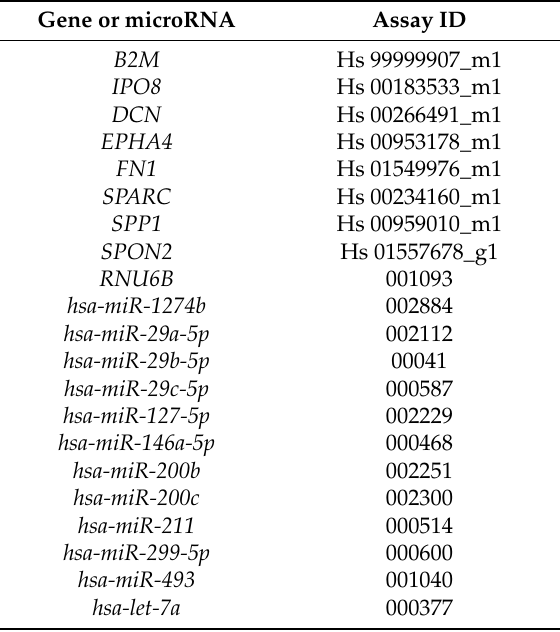
Table 3. List of used TaqMan